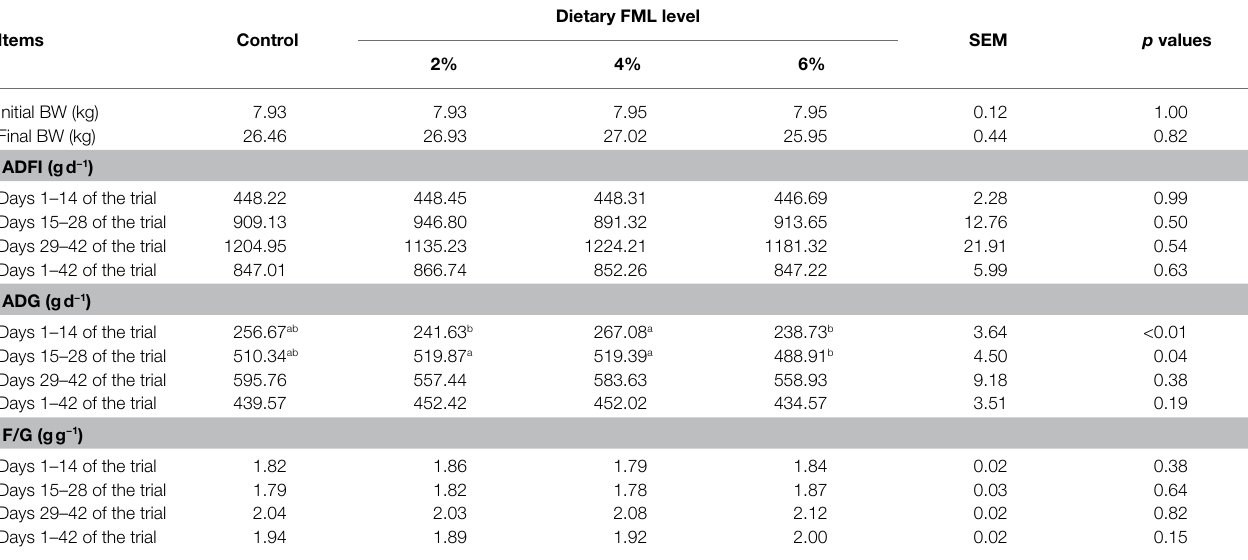
TABLE 1 | Effects of dietary supplementation with fermented Mao-tai lees (FML) on growth performance of weaned piglets.